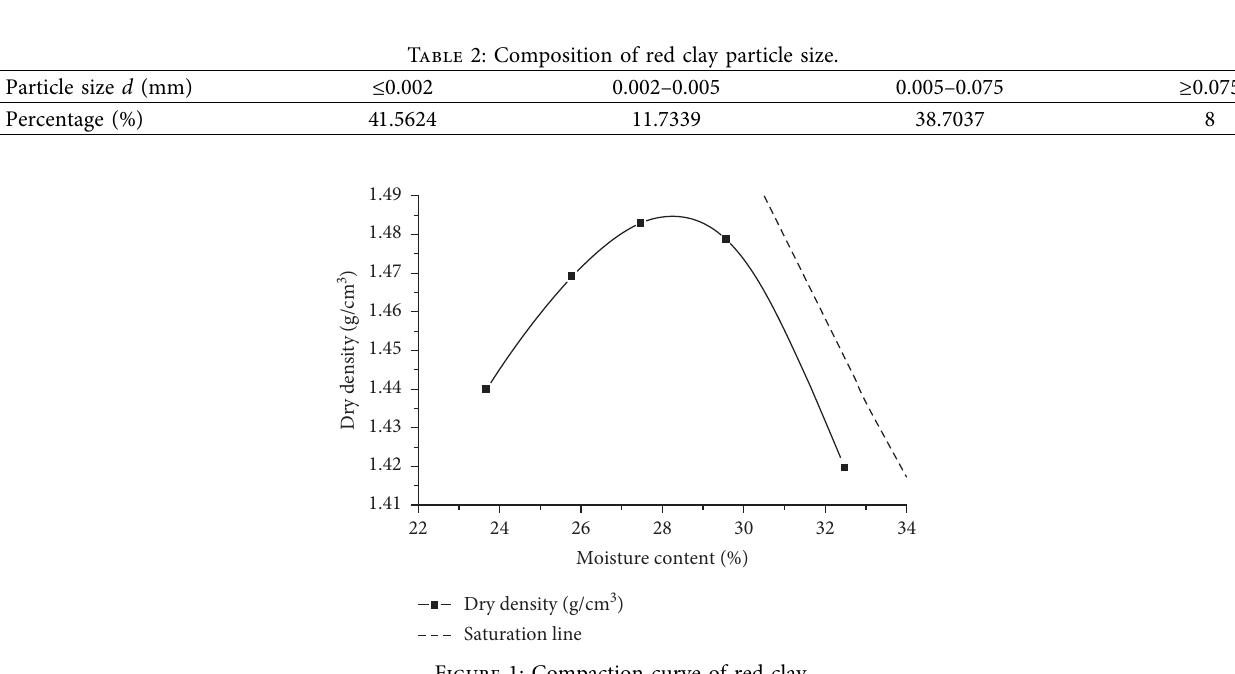
Table 1: Physical properties of red clay for testing.